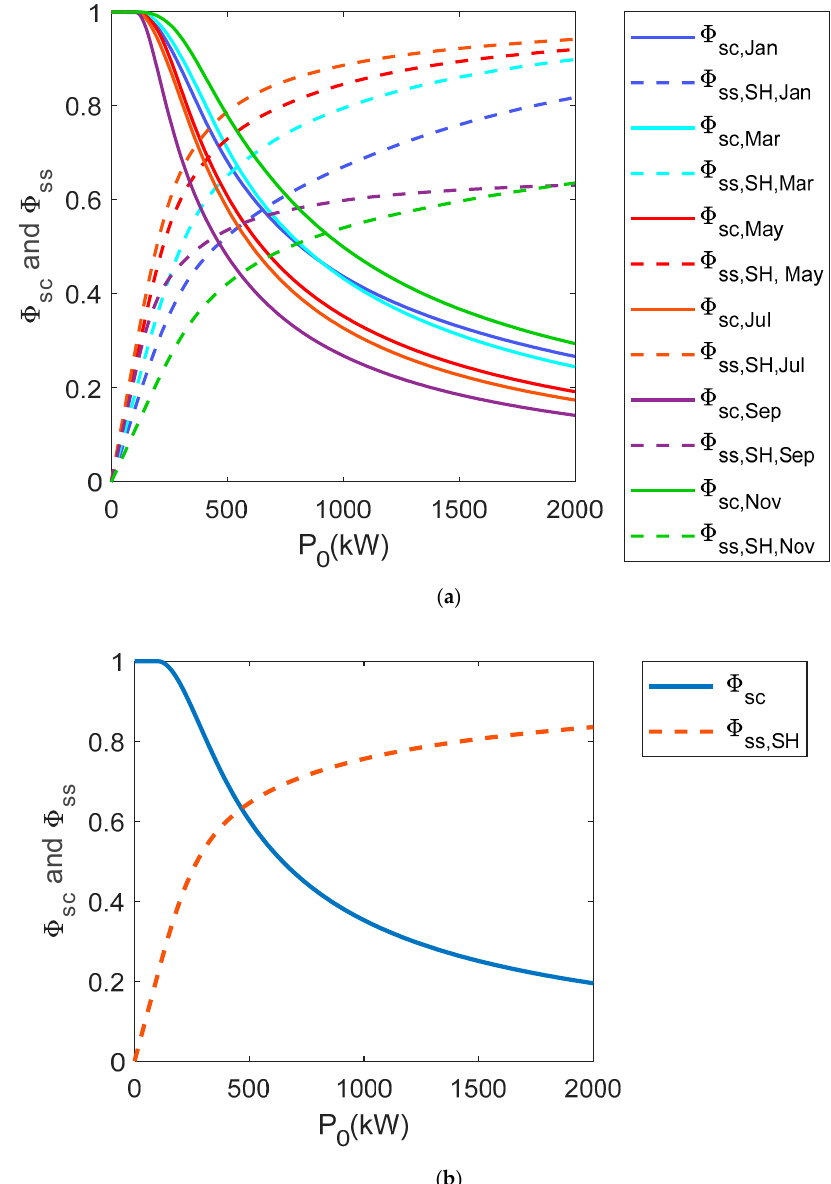
Figure 10. ( a ) Monthly self-consumption and self-sufficiency during curves sunshine hours; ( b ) Annual self-consumption and self-sufficiency curves during sunshine hours. Industry B.